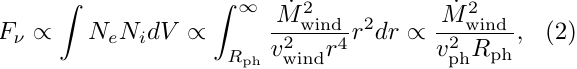
Figure 2: Free-free emission model light curves for var- ious WD masses from 0 . 55 M (cid:12) to 1 . 2 M (cid:12) in steps of 0 . 05 M (cid:12) (taken from Hachisu & Kato 2010). Open squares denote observational y magnitudes of V1668 Cyg that show good agreement with the 0 . 95 M (cid:12)